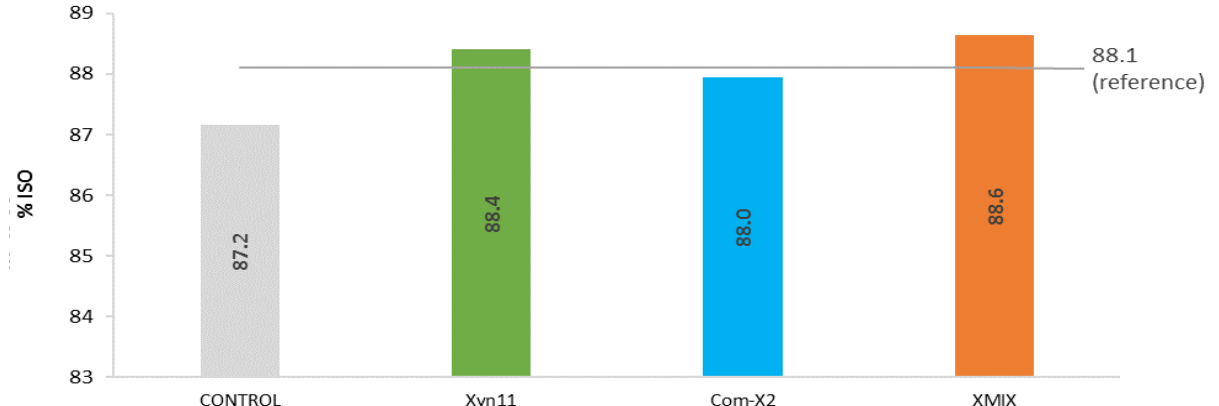
Figure 4. Final pulp brightness obtained after 5 h prebleaching stage with different xylanases followed by 15% less ClO 2 applied in each D step of the bleaching sequence.